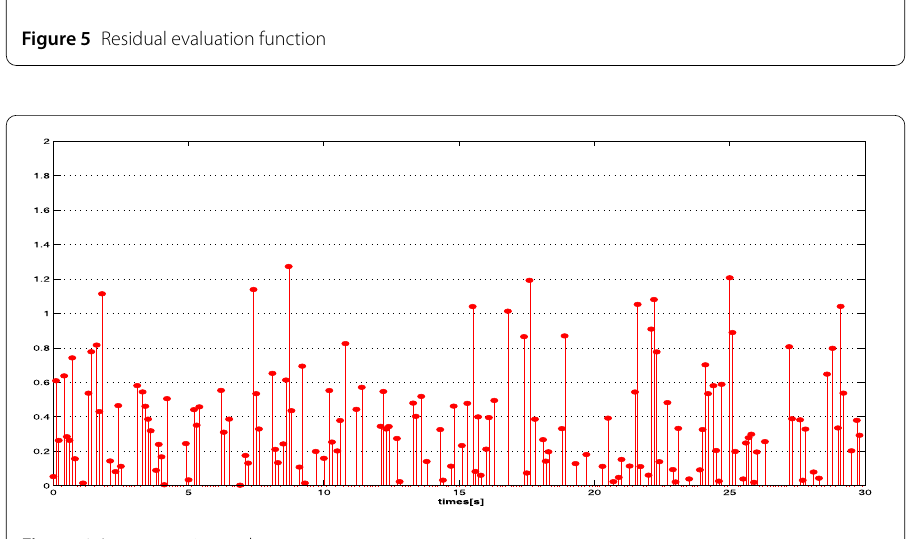
Figure 5 Residual evaluation function